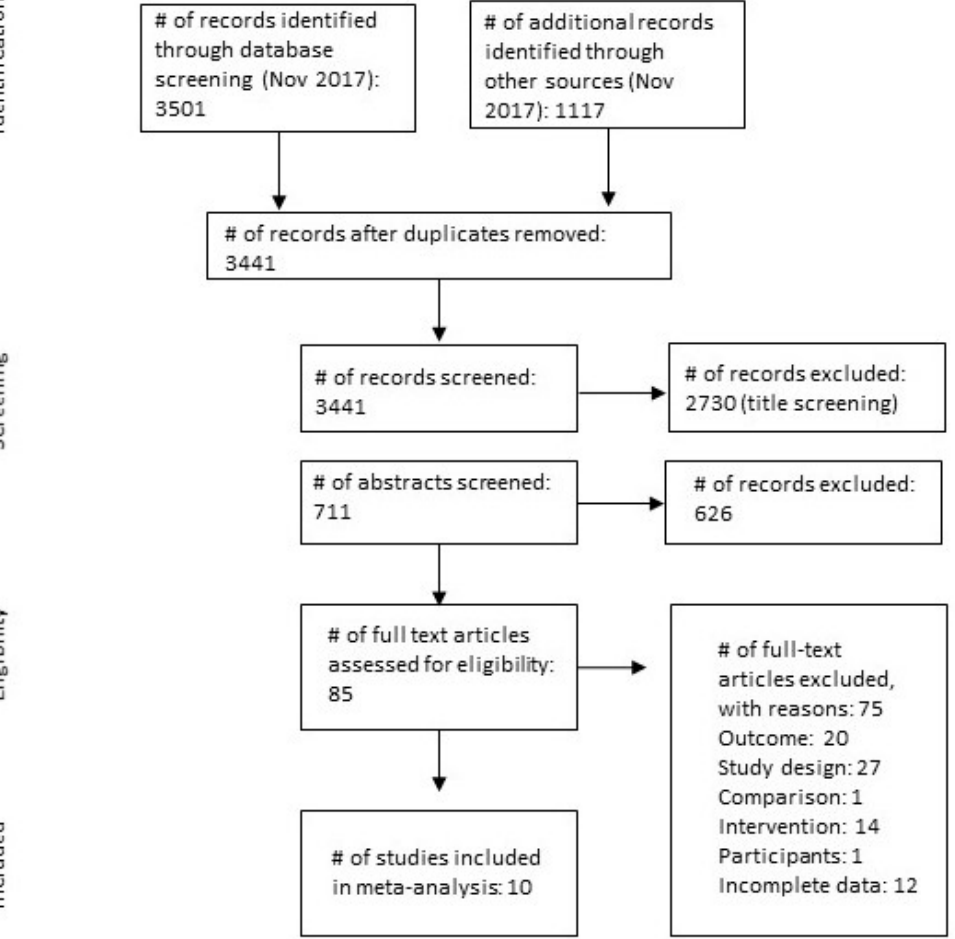
Figure 1. Study selection process. Preferred Reporting Items for Systematic Reviews and Meta-Analyses (PRISMA) flow diagram [30].